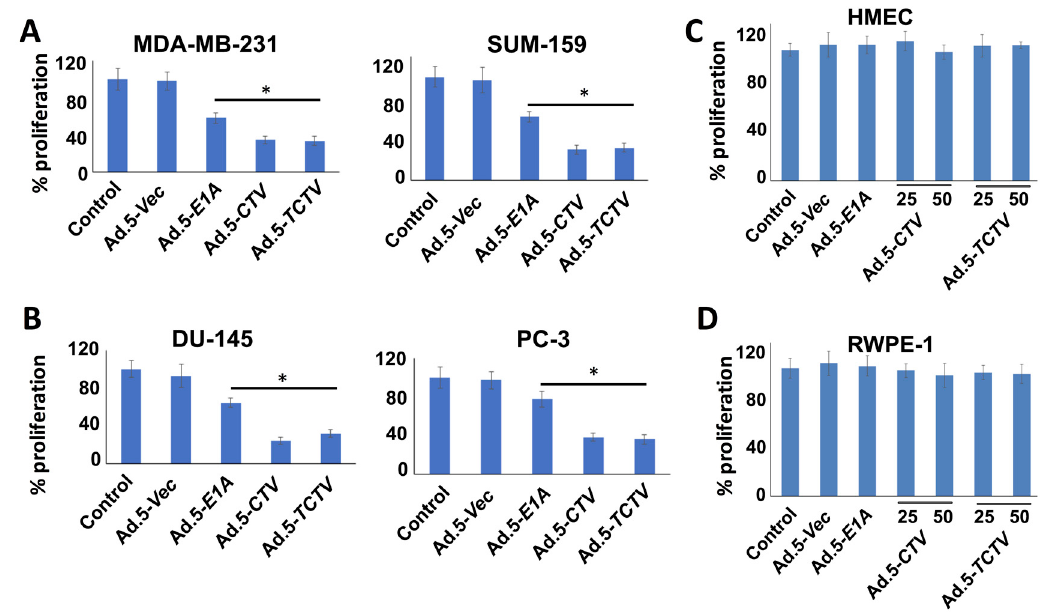
Figure 2. Ad.5- TCTV inhibits cancer cell proliferation to a similar extent as Ad.5- CTV . ( A – D ) The indicated cell types (5000 cells), ( A ) human breast cancer (MDA-MB-231 and SUM-159); ( B ) human prostate cancer (DU-145 and PC-3); ( C ) primary normal human breast epithelial (HMEC); and ( D ) normal immortal prostate epithelial (RWPE-1) cells were plated in 96-well plates and infected with either Ad.5- E1A (25 pfu), Ad.5- CTV (25 pfu), or Ad.5- TCTV (25 pfu) for 72 h. These cells were then treated with 20 μ L of MTT in phosphate-buffered saline (PBS) and incubated further for 4 h. Media was then removed and formazan crystals were dissolved using dimethyl sulphoxide (DMSO) (100 μ L). A microplate reader was used to measure the absorbance at 550 nm and the results are presented as percent proliferation with the comparison of cells treated with vehicle. Points, mean of triplicate experiments; bars, S.E. * p < 0.05 vs. control.